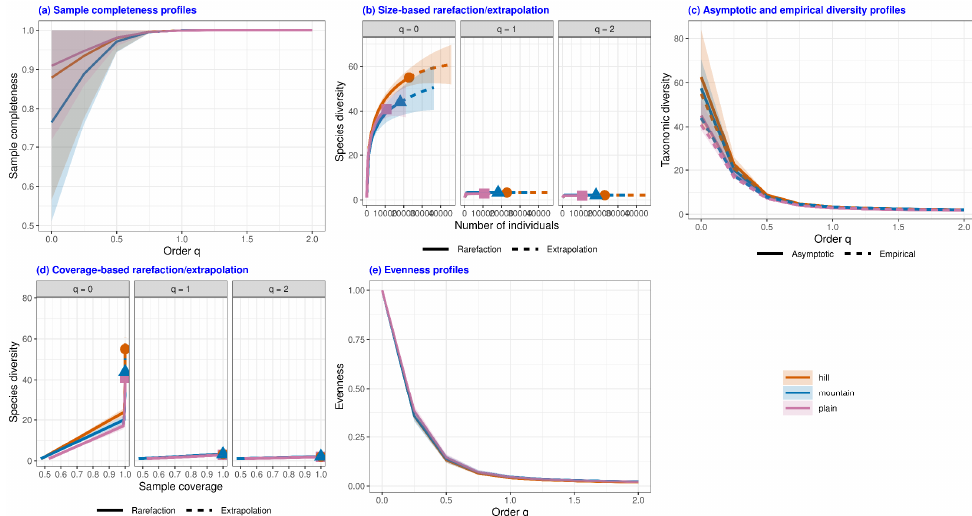
Figure 5. ( a ) The sampling plots of estimated sample completeness curves as a function of order q between 0 and 2 in the hill landform (Sobs = 55, n = 22,871), mountain landform (Sobs = 44, n = 18,150), and plain landform (Sobs = 41, n = 10,678). ( b ) Size-based rarefaction (solid lines) and extrapolation (dashed lines) curves up to double the reference sample size. ( c ) The asymptotic estimates of diversity profiles (solid lines) and empirical diversity profiles (dotted lines); numerical values refer to the estimated asymptotic diversities. ( d ) Coverage-based rarefaction (solid lines) and extrapolation (dashed lines) curves up to the corresponding coverage value for a doubling of each reference sample size. ( e ) Evenness profile as a function of order q, 0 < q ≤ 2, based on the normalized slope of Hill numbers. Solid dots and triangles denote observed data points. All shaded areas in ( a – d ) denote 95% confidence bands obtained from a bootstrap method with 100 replications. Table 3. The numerical values for the three special cases of q = 0, 1 and 2 for abundance-based soil faunas collected.